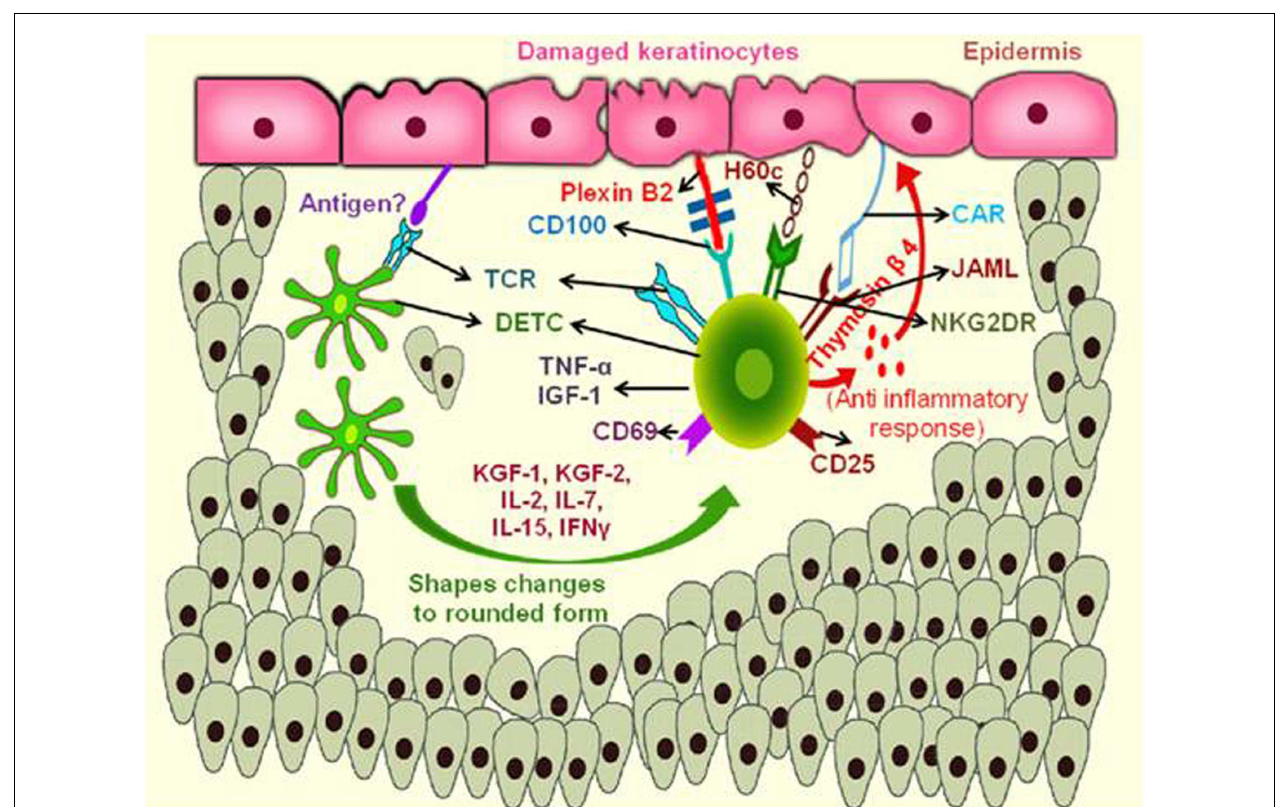
FIGURE 2 | Mechanism of action of murine skin resident γδ T cells in wound repair . During keratinocyte damage, the epidermal γδ T cells (DETCs) are activated upon recognition of an unknown antigen, rounding of the DETCs occur and produce thymosin β 4 and cytokines likeTNF- α , IFN- γ , and IL-2 required for anti-inflammatory response and wound